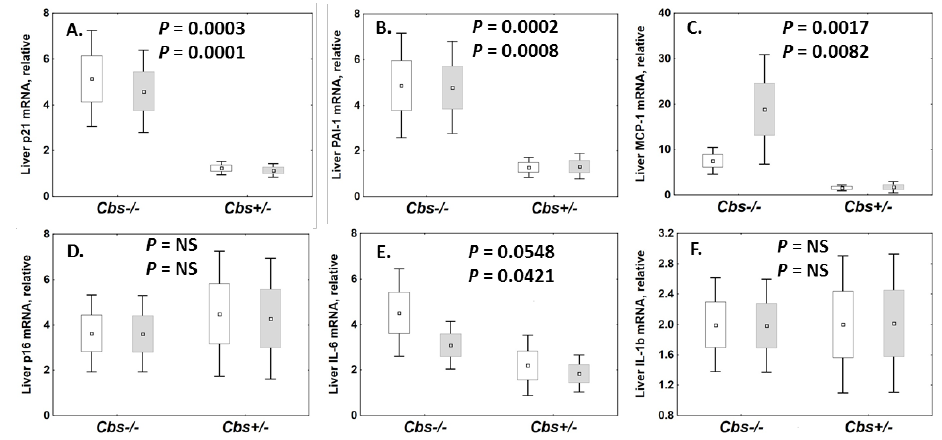
Figure 1. Box plots illustrating the effects of the Cbs genotype on the expression of senescence-related mRNAs in liver. The following mRNAs were quantified by qPCR in Cbs −/− mice ( n = 21) and sex- and age-matched control Cb +/− siblings ( n = 22): A . p21 , B . Pai-1 , C . Mcp-1 , D . p16 , E . Il-6 , and F . Il-1β . Box and whiskers represent the mean ± SEM and the mean ± 95% CI, respectively. Upper and lower p -values refer to data normalized to β-actin (blank boxes) and Gapdh (gray boxes) mRNAs, respectively. NS, not significant.